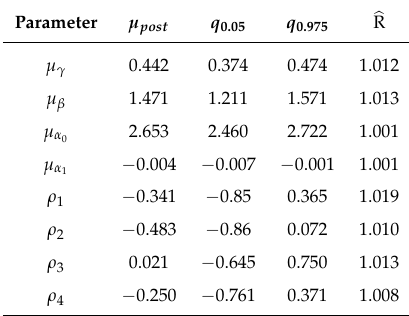
Table 1. Marginal posterior distributions statistics: Posterior mean ( µ post ), 95% credible